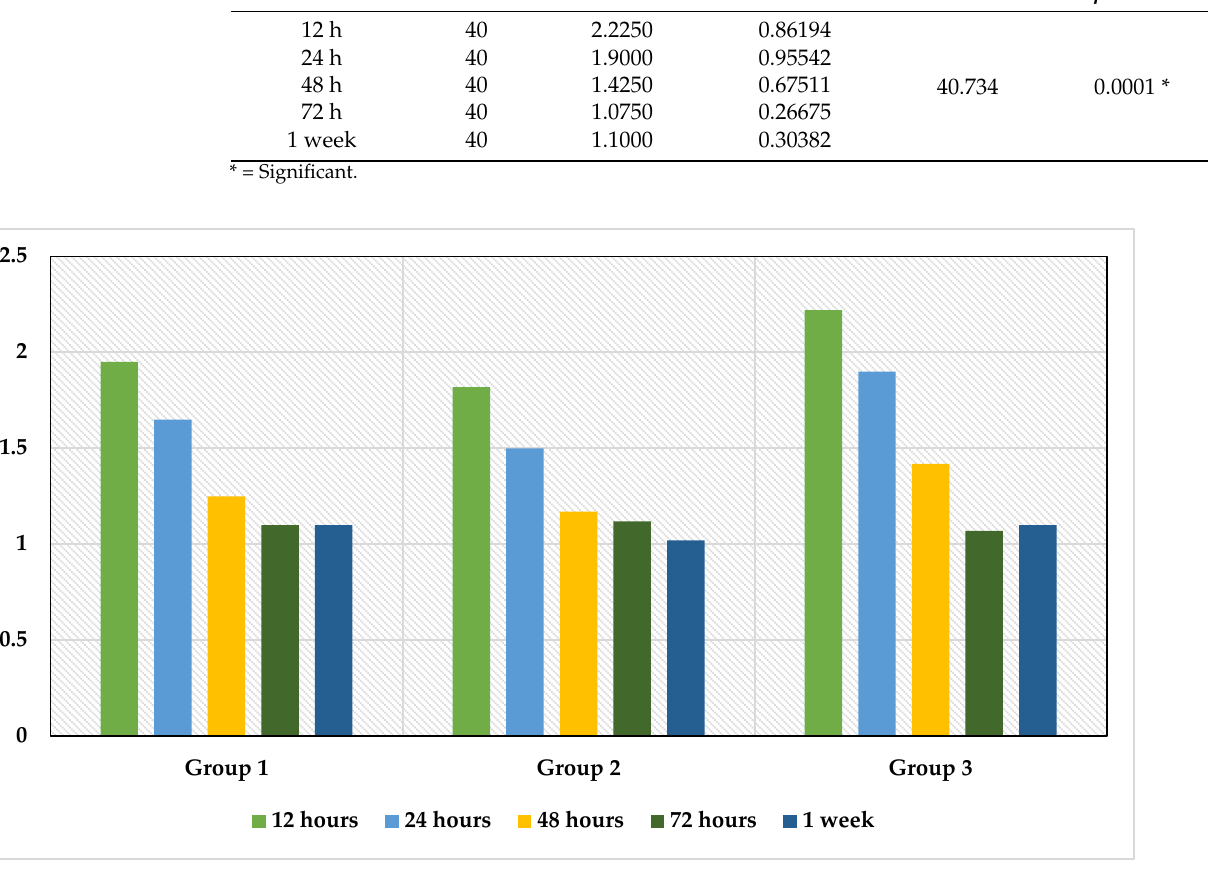
Figure 2. VAS scores across five timepoints for the three experimental groups. Table 9. VAS readings between